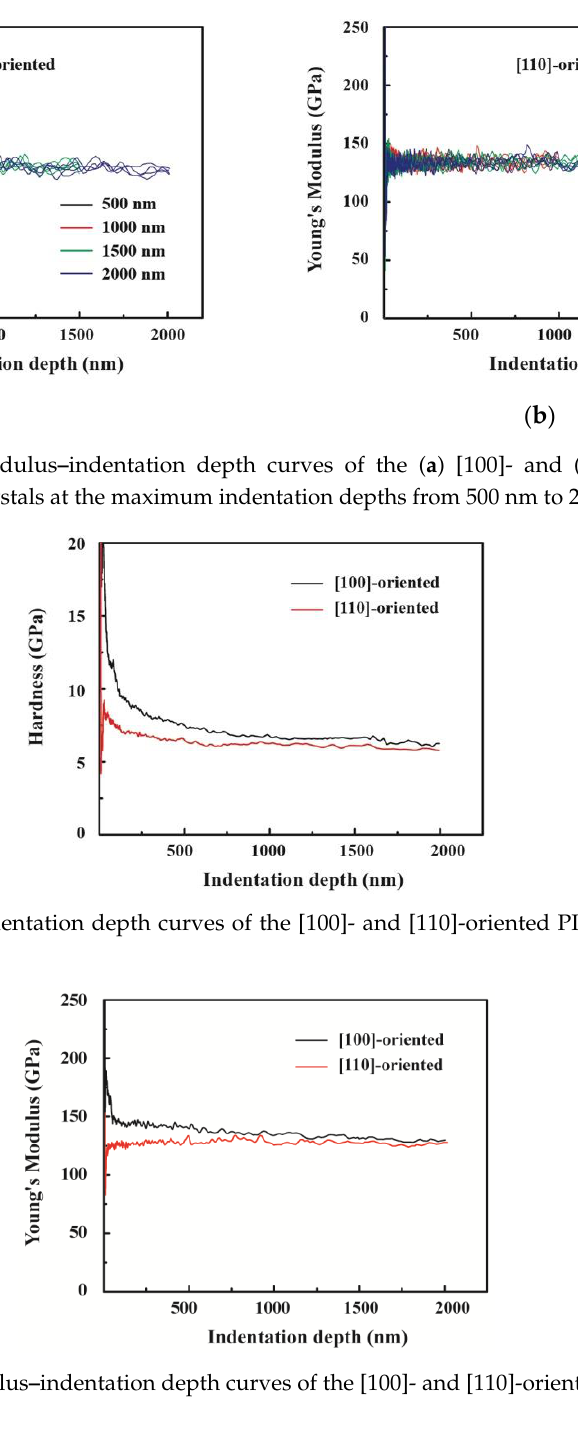
Figure 8. Young’s modulus – indentation depth curves of the [100]- and [110]-oriented PIN–PMN–PT bulk single